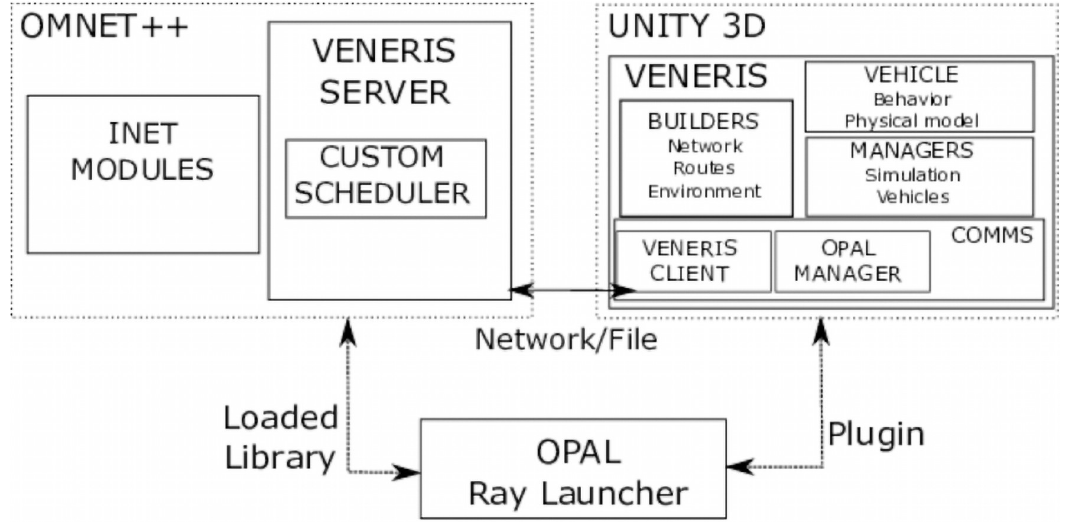
Fig 1. Veneris main components. Opal can be used as a standalone application, as a plugin with Veneris or loaded with